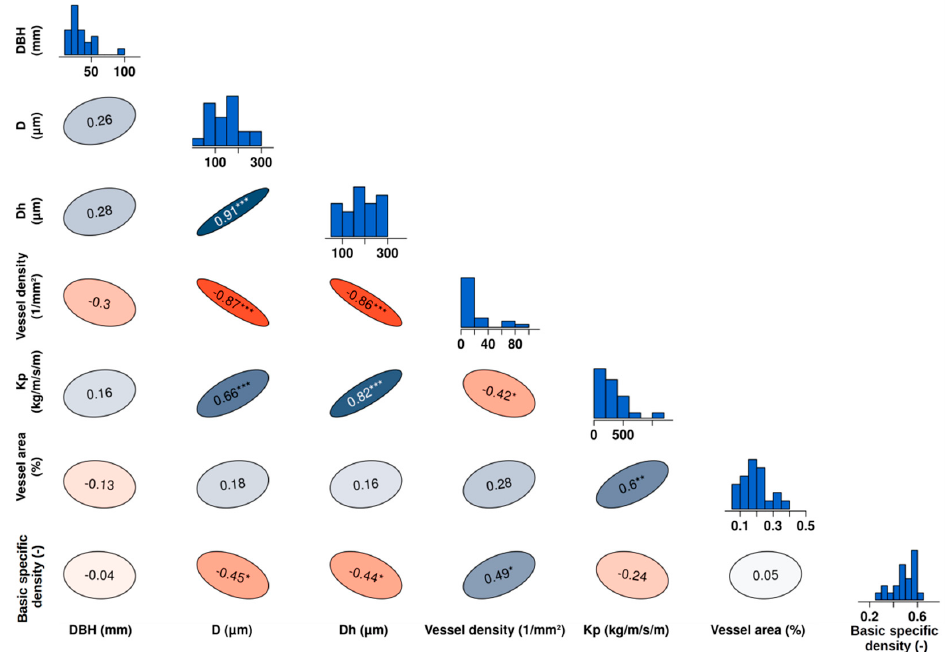
Figure 2. Correlogram between individual wood sample traits of the whole liana dataset. The main diagonal shows the frequency distributions of these variables while the other plots represent the correlation between the corresponding variables alongside with the Pearson’s coefficient and its significance according to the no-correlation test (*** p -value < 0.001, ** p -value < 0.01, * p -value < 0.05). Vessel density, mean diameter D , hydraulically-weighted diameter D h , and maximum stem hydraulic conductivity K p , were log10-transformed to compute the Pearson correlation coefficients. Some of the significant correlations are obvious ( D and D h for instance) and derive from the way we calculated them from one another (see Section 2). DBH = diameter at breast height, D = mean vessel diameter, D h = hydraulically weighted mean diameter, K p = maximum stem conductivity.